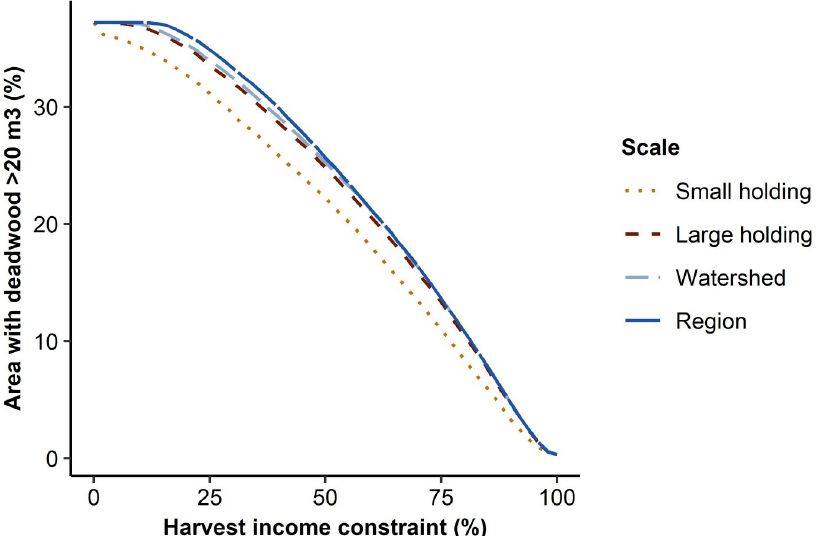
Fig 5. Proportion of forest area with high deadwood availability. Proportion of forest area with deadwood availability greater than 20 m 3 /ha at different harvest income requirements and under forest management optimized at different spatial scales.